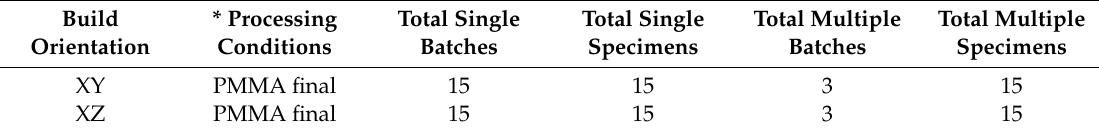
Table 3. The number of batches and specimens prepared in di ff erent orientations.